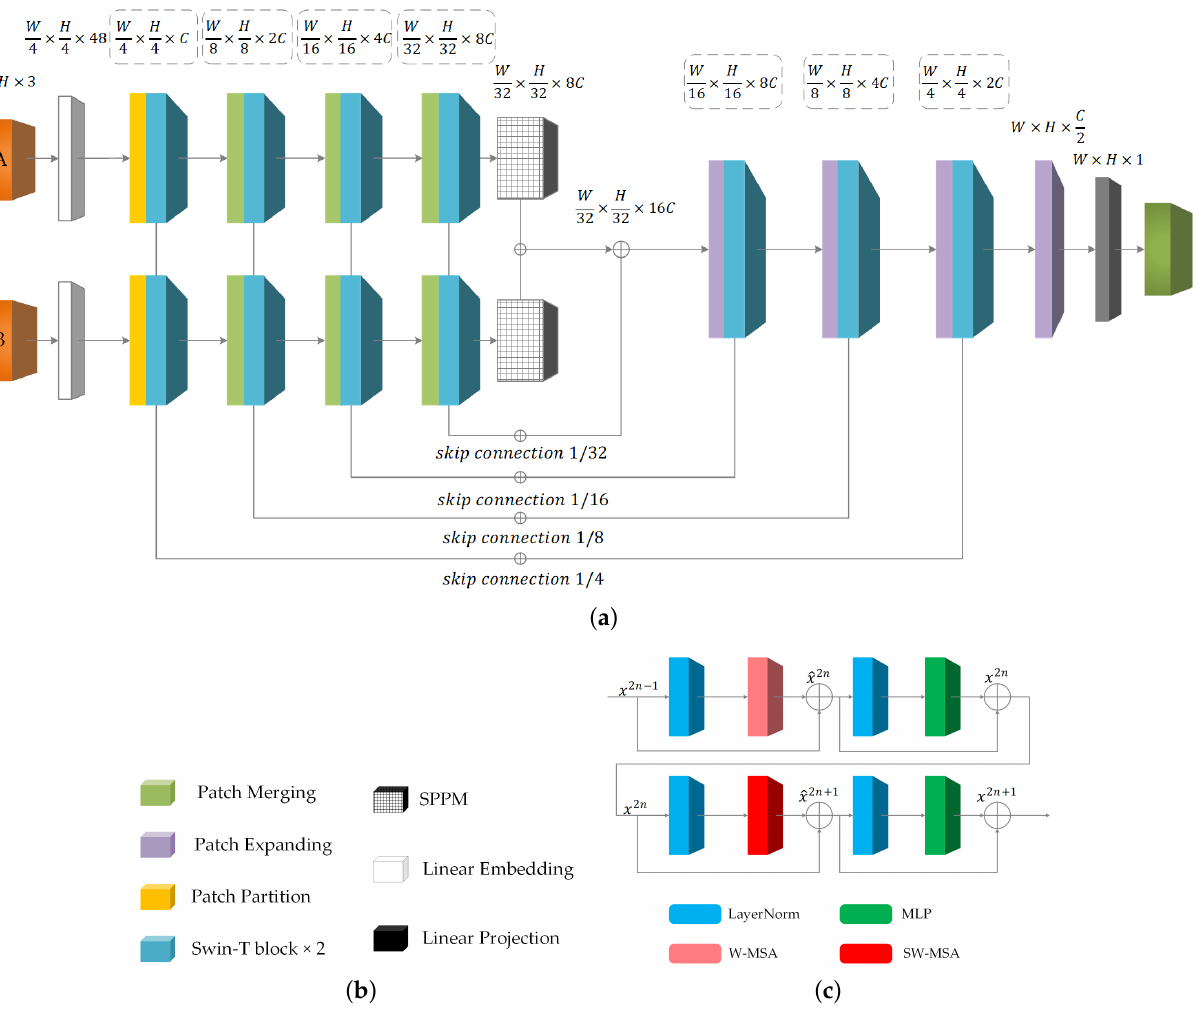
Figure 2. ( a ) The overall structure of SWUNet-CD; ( b ) the name of each layer; ( c ) the schematic diagram of two consecutive Swin-T